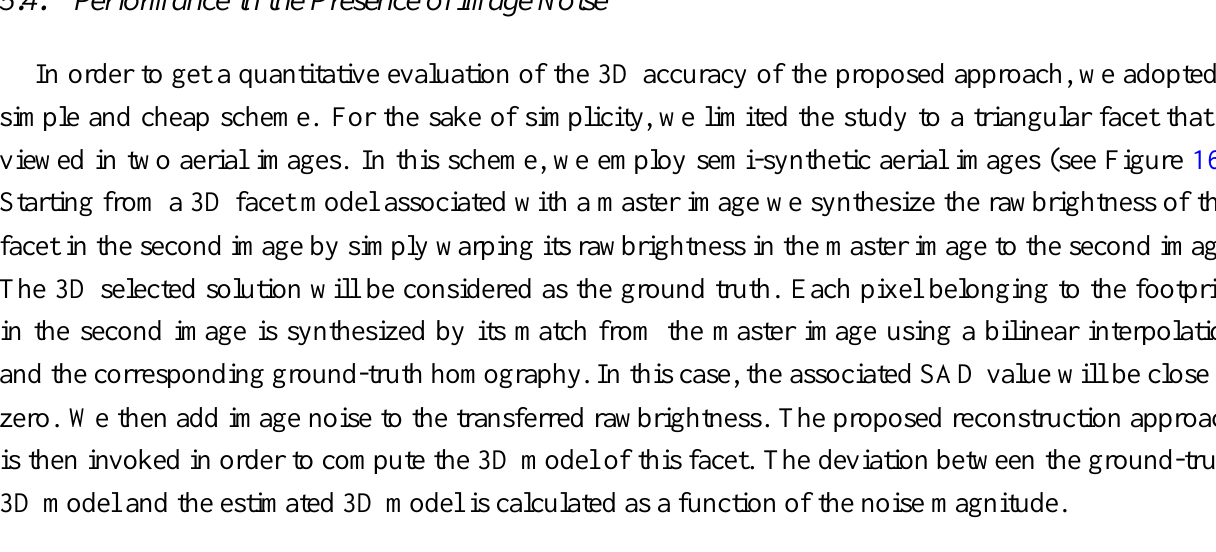
Figure 16. Adding noise to a facet for robustness evaluation. The intensities of the gray-scale pixels belong to the interval [0,255]. The magnitude M of the uniform noise progressively increases according to the respective intervals M 1 = [ − 4 , 4] , M 2 = [ − 8 , 8] , M 3 = [ − 16 , 16] and M 4 = [ − 32 , 32] . These four levels of noise are shown in (b) (the corresponding random noise affected the bottom